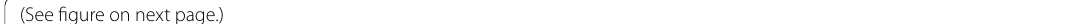
(See figure on next Fig. 4 A. Locality map of the Tierwis section and photographs of Tierwis Hütte ( B ) and Tierwis-Grenzchopf ( C – F ) outcrops. B View of the Tierwis Hütte outcrops with the incriminated formations. C View of the Tierwis-Grenzchopf outcrop with the incriminated formations and main beds. D Polyphased hardground at the boundary between the Altmann Member and the Drusberg Member (D7). E Firmground with bored pebbles in the lower part of the Drusberg Member (D8). F Oyster-rich firmground at the boundary between the carbonate-dominated succession and the marly interval composing the Drusberg Member